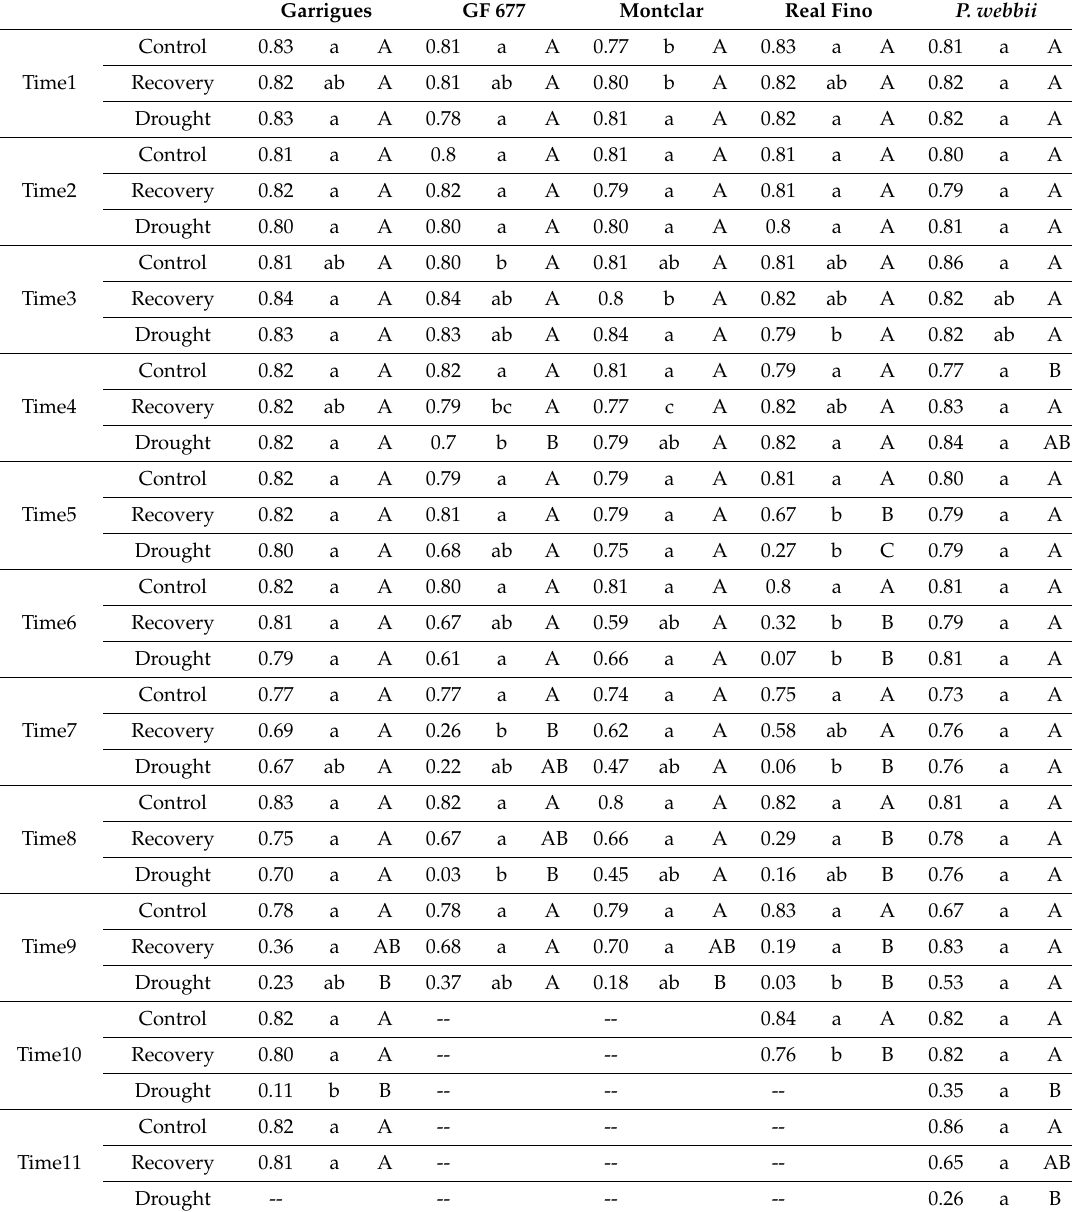
Table 6. Mean values for the Fv / Fm. Means with at least one identical lowercase letter within a column are not significantly di ff erent from each other between genotypes. Means with at least one identical uppercase letter within a row of each time point are not significantly di ff erent from each other between treatments ( p <